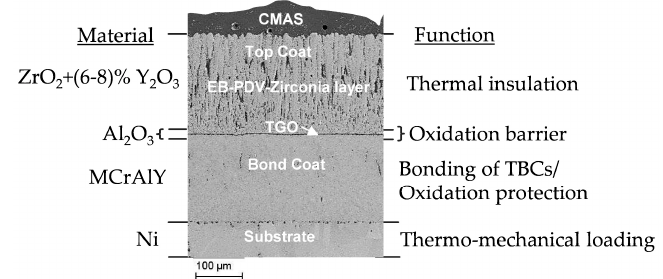
Figure 1. Cross-section of electron beam physical vapor deposition (EB-PVD) fabricated thermal barrier coating (TBC) showing layered structure with deposited calcium–magnesium–alumina–silicates (CMAS) on top.